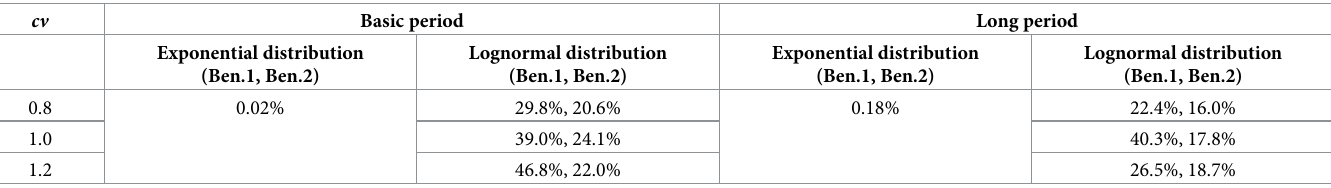
Table 8. Social welfare improvement compared to two benchmark approaches.